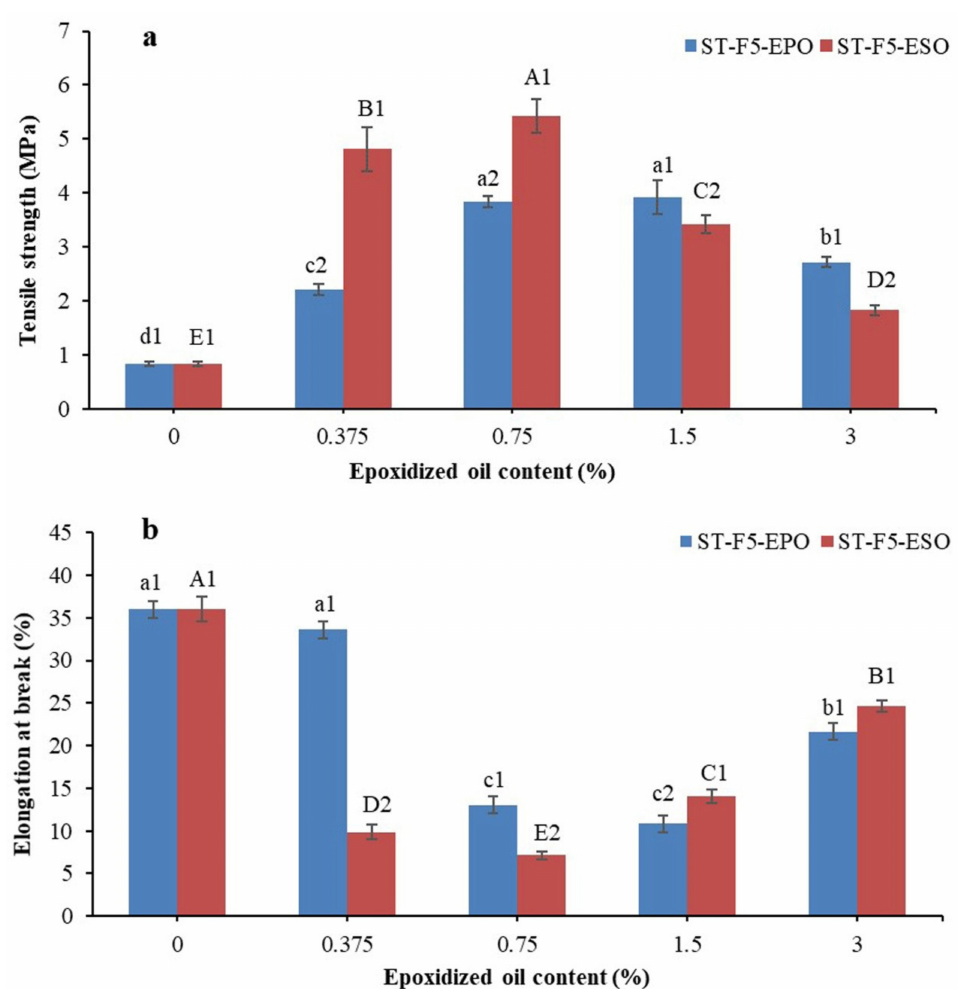
Figure 6. Tensile strength ( a ) and elongation at break ( b ) of the bioplastic composites. In regard to a–d and A–E, different letters within the same indicator indicate significant difference among samples ( p < 0.05). (1 and 2) Different numbers indicate significant difference between the formulations with palm oil (PO) and EPO at the same concentration ( p <